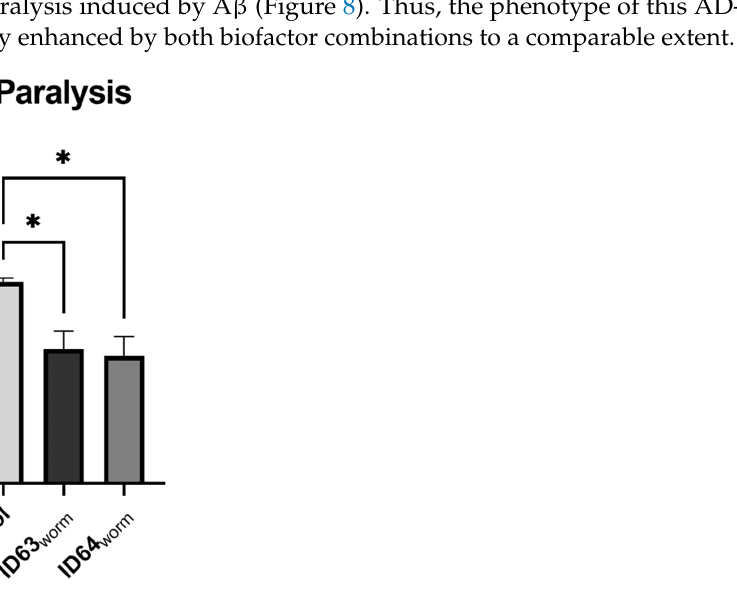
Figure 8. The A β induced paralysis after treatment with either ID63 worm or ID64 worm in GMC101. Both the feeding of both treatment combinations leads to significant reduction of A β induced paralysis after incubation of the nematodes for 24 h at 25 ◦ C. N = 4. Mean ± SEM. One-way ANOVA with Tukey’s comparison post hoc test. p * < 0.05 ID63 worm = Fol 50 µ M and MgOr 100 µ M; ID64 worm Fol 50 µ M, MgOr 100 µ M and Vit B6 100 µ M.